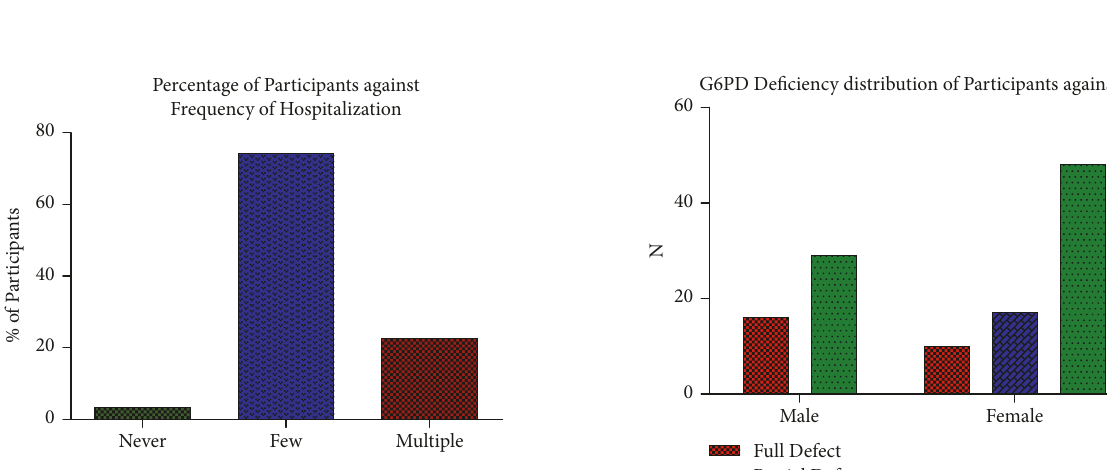
Figure 2: The graph above shows the distribution of the extent to which participants are hospitalized. One (1) represents those who have not being hospitalized, (2) represent those hospitalized for few times, and (3) represent those hospitalized multiple times.